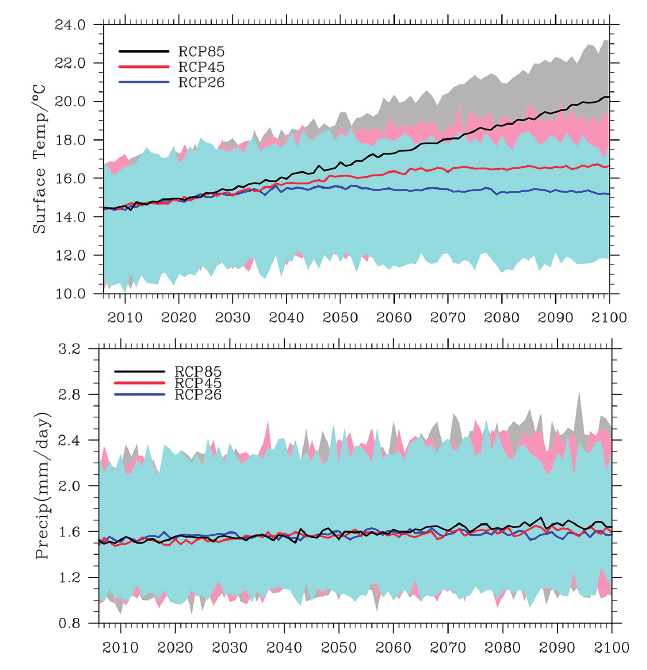
Figure 3. Ensemble mean temperature and precipitation simulations by BMA during the growing season from 2006–2100 in three scenarios (RCP 26, RCP 45 and RCP